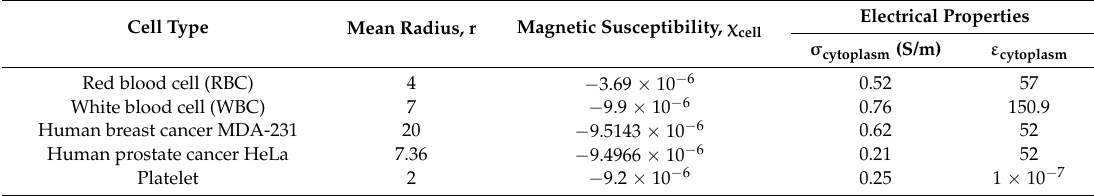
Table 1. The dielectric and magnetic parameters of cells used for device